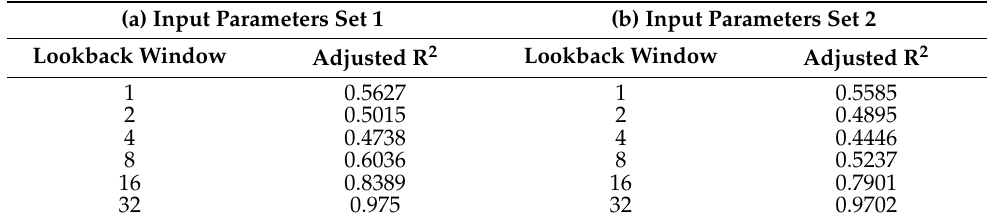
Table 5. Accuracy score for each LSTM network